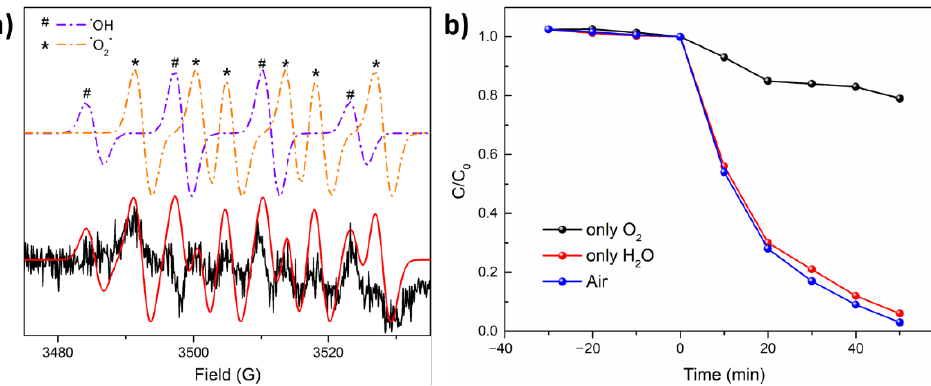
Figure 6. ( a ) EPR spectra of CsPbBr 3 /Bi 2 WO 6 sample saturated with air under illumination for 5 min and 5,5-dimethyl-pyrroline N-oxide (DMPO) was used as trap agent; ( b ) photocatalytic degradation rate of 15 wt% CsPbBr 3 /Bi 2 WO 6 sample when saturated with different gases.